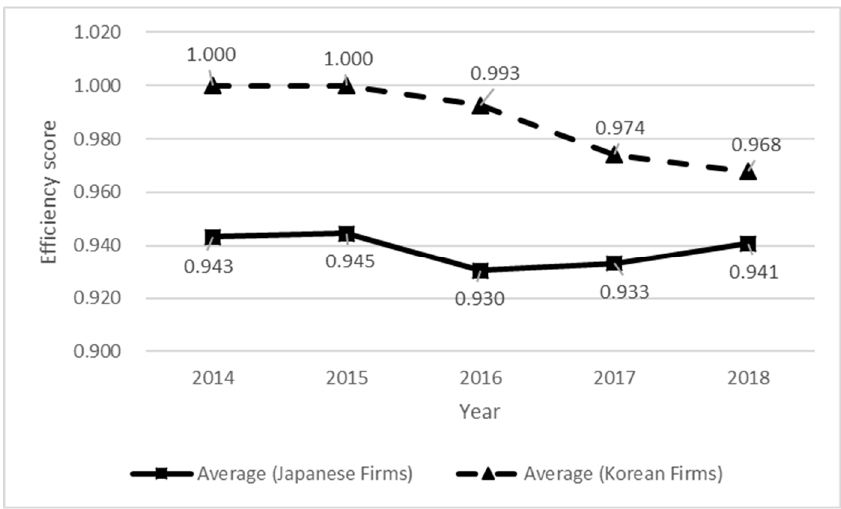
Figure 3. Average Efficiencies of Japanese and Korean Power Companies over Time. Note: ( a) The vertical Figure 3. Average E ffi ciencies of Japanese and Korean Power Companies over Time. Note: (a) coordinate indicates average operational efficiency measure of Japanese and S. Korean electric power The vertical coordinate indicates average operational e ffi ciency measure of Japanese and S.